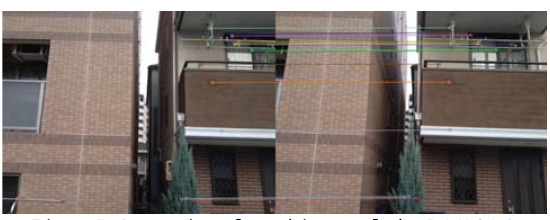
Figure 4. Incorrect matching by SURF